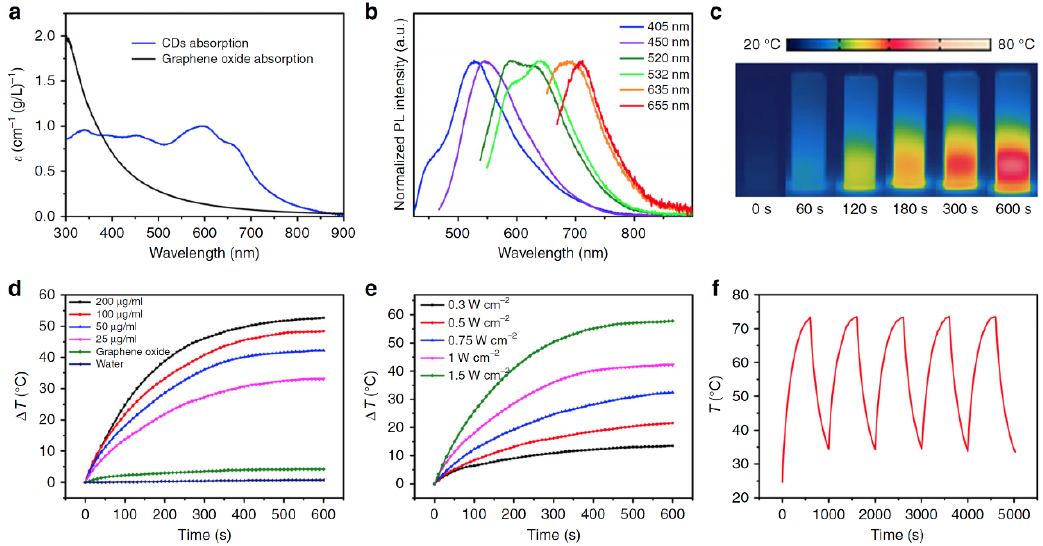
Figure 8. ( a ) Absorption spectra of sulfur-doped C-Dots in aqueous solution. The data from graphene oxide for comparison. ( b ) Emission spectra of the C-Dots that are excited at various wavelengths in dilute aqueous solution. ( c ) Photothermal images of the aqueous solutions of C-Dots (200 µg mL −1 ) that were captured at various times under 655-nm laser irradiation at a power density of 1 W cm −2 . ( d ) Temperature evolutions of the C-Dots at various concentrations. The data from graphene oxide at 50 µg mL −1 and from pure water measured under the same conditions are shown for comparison. ( e ) Temperature evolutions of the C-Dots (50 µg mL −1 ) at various power densities. ( f ) Temperature curves of the C-Dots (200 µg mL −1 ) under five cycles of photothermal heating under 655-nm laser irradiation (1 W cm −2 ). Reproduced with permission from [83]. Copyright, Springer Nature (2020).